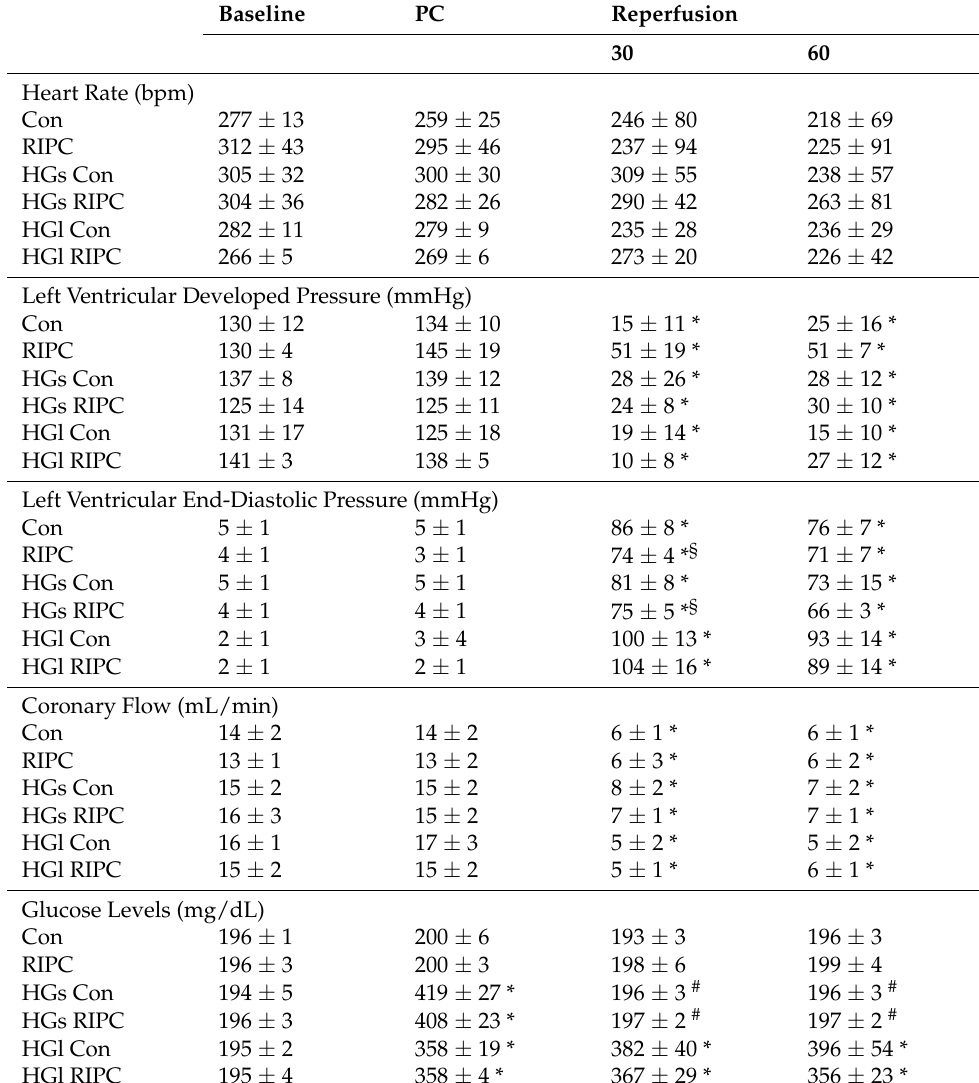
Table 2. Hemodynamic variables and glucose